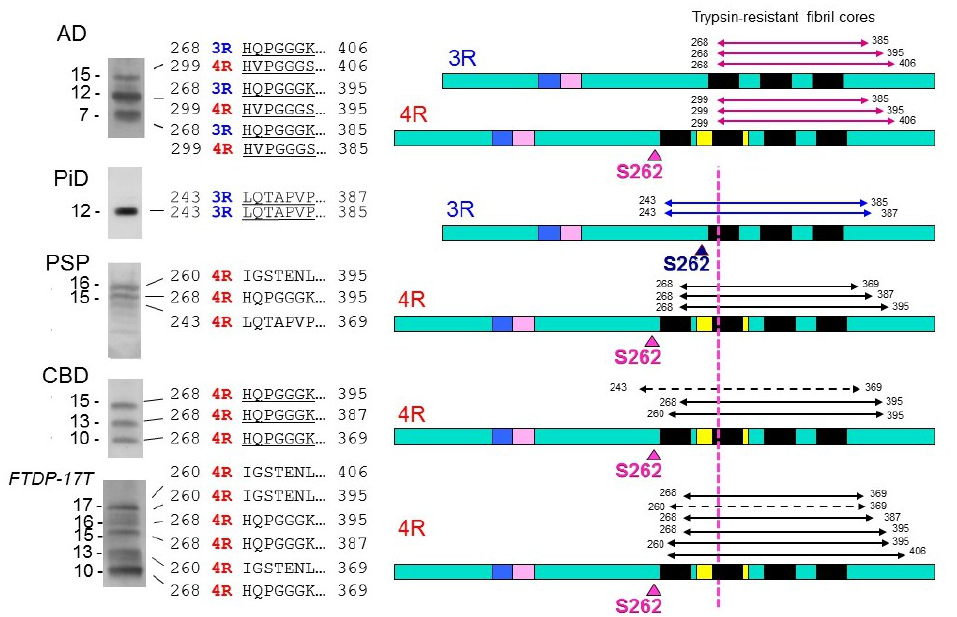
Figure 3. Trypsin-resistant tau bands in tauopathies, the N-terminal sequences of the tau species, and schematic diagrams of the regions in 3R and 4R tau molecules. The major trypsin-resistant regions of tau identified by protein sequencing, MALDI-TOF and LC/MS/MS analyses are shown by solid lines, and minor ones by broken lines. In PiD, Ser262 is in the trypsin-resistant region, which may be buried in the fibril cores, and this may be the reason why Ser262 is not phosphorylated in PiD, whereas it is partially phosphorylated in the other tauopathies.